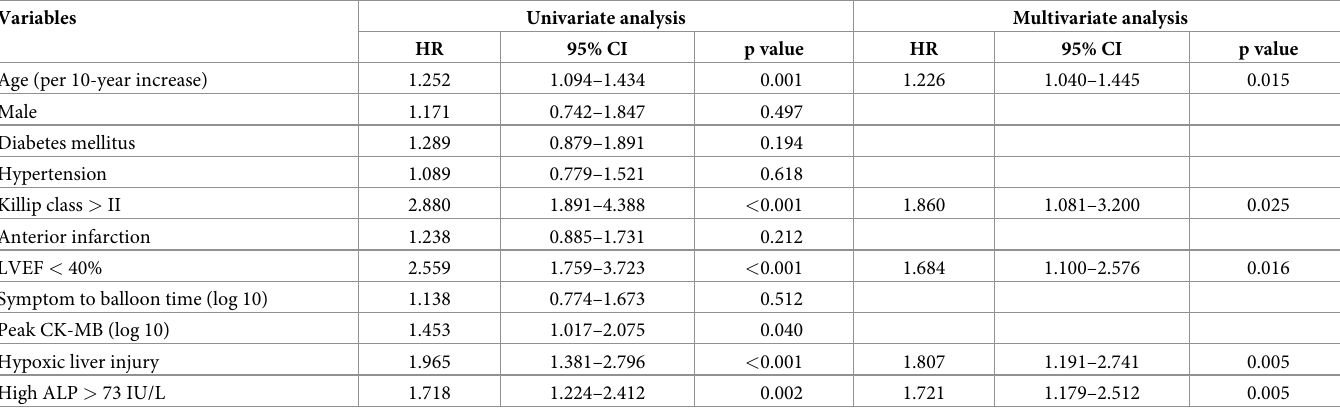
Table 4. Predictors of major adverse cardiac and cerebrovascular events.